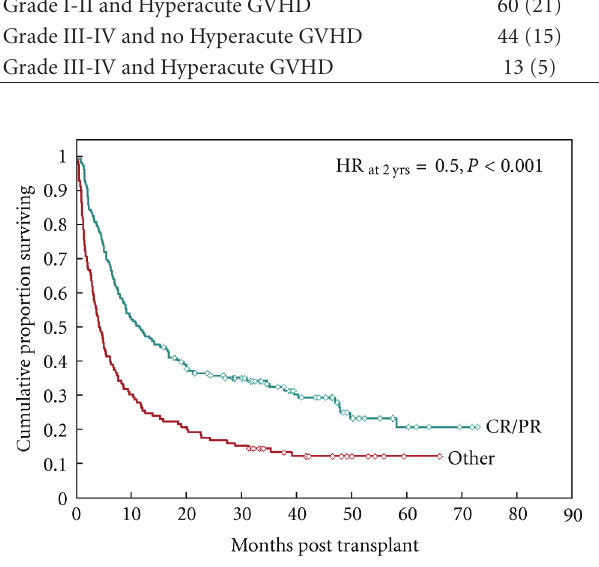
Figure 1: Overall survival in steroid responsive and refractory aGVHD patients.